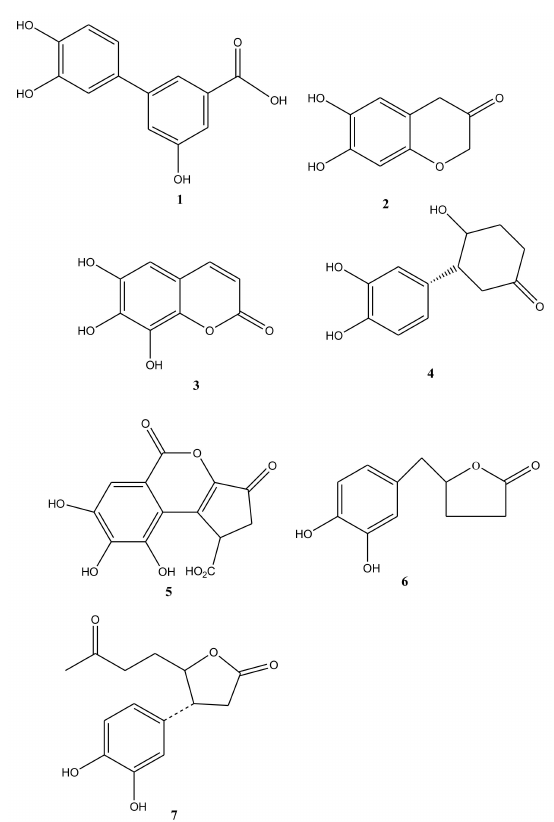
Figure 1. Structures of compounds ( 1 )–( 7 ) from water-soluble extracts of Castanea mollissima shells.